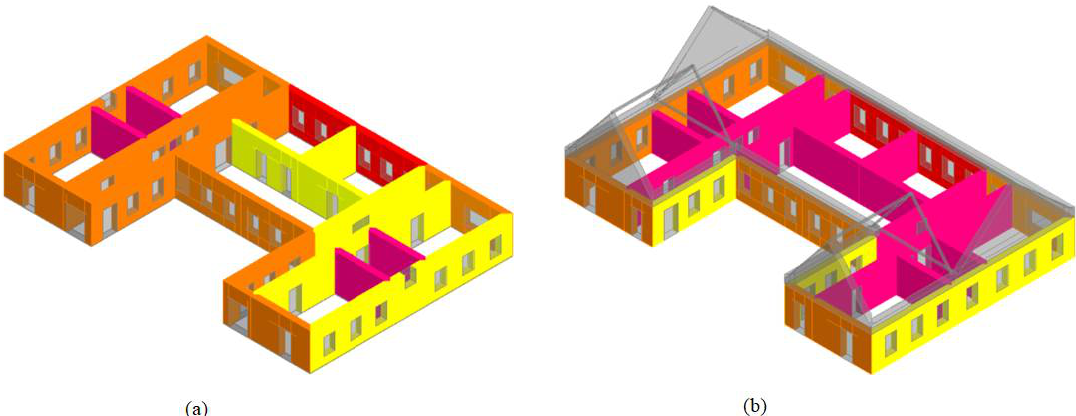
Figure 20. Configuration of different FRP systems: ( a ) on the ground floor; ( b ) on the first floor.